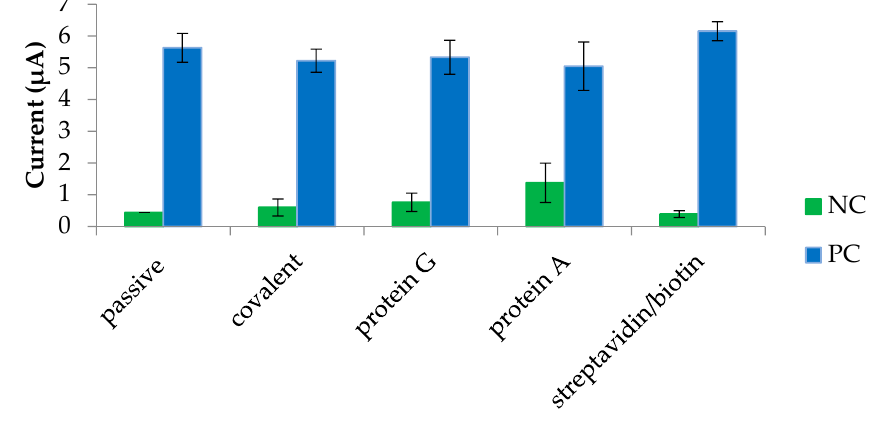
Figure 2. Comparison of various immobilisation techniques for the goat anti-human IgM capture antibody. NC: negative control consisting of a dengue IgM negative serum sample; PC: dengue IgM positive serum sample.